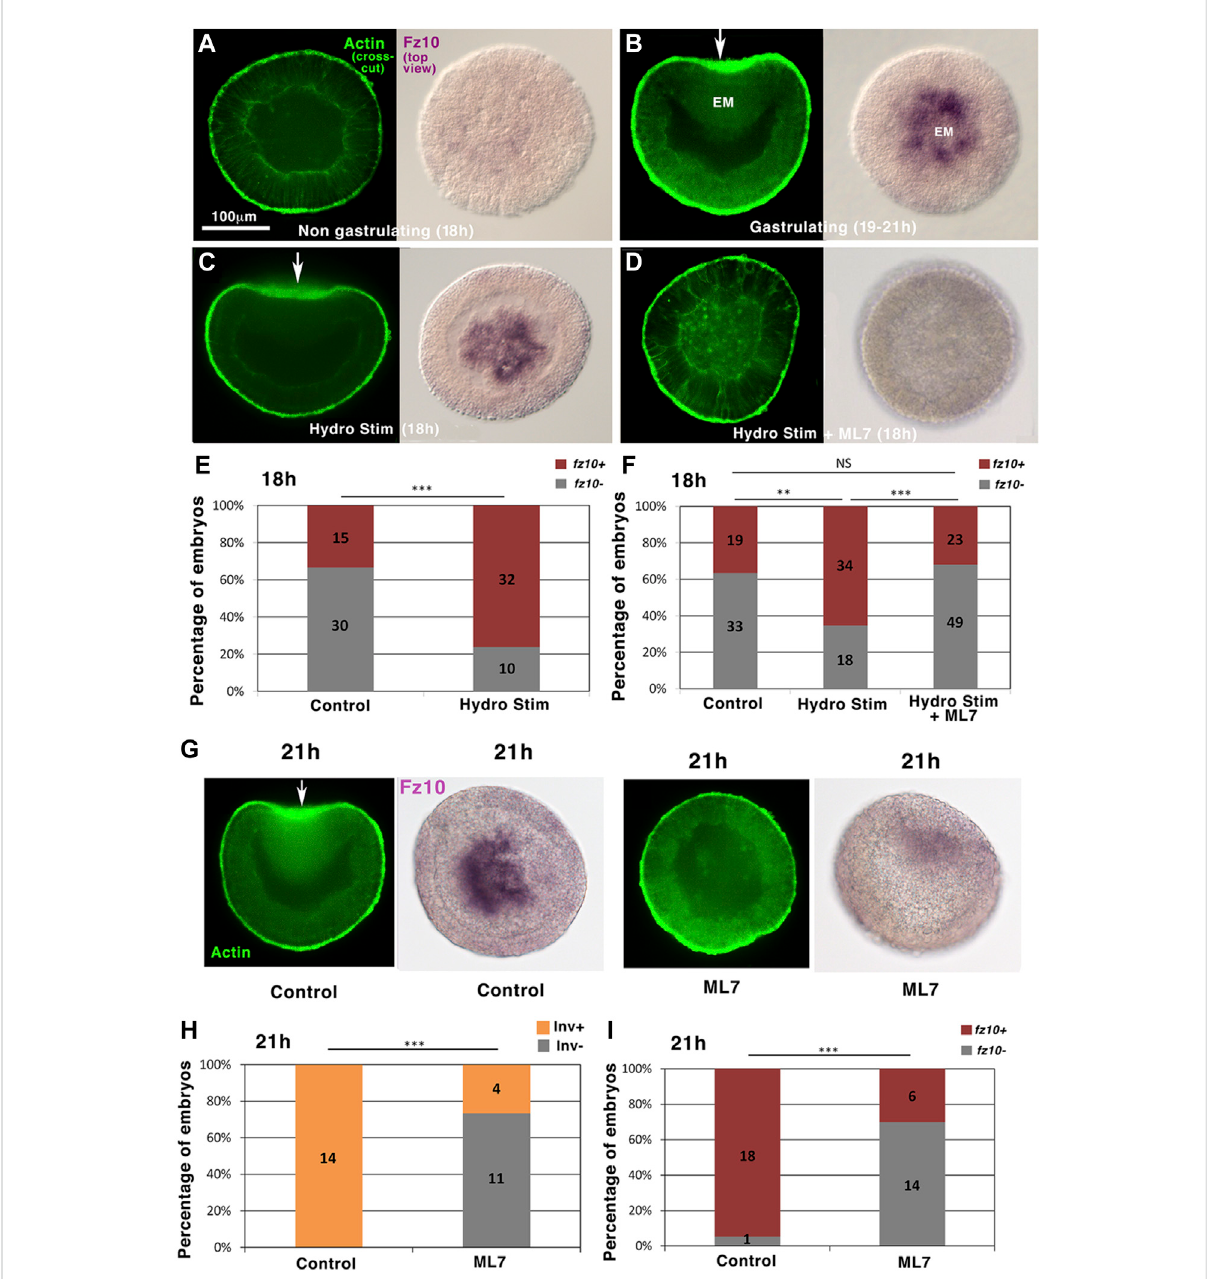
FIGURE 3 Hydrodynamically induced and endogenous gastrulation of Nematostella embryos stimulates the endomesodermal fz10 gene expression downstream of mechanical stimuli in a Myo-II-dependent process. (A) fz10 expression in 18 h non-invaginating embryos (B) and in the invaginating endomesoderm of 21 h embryos. (C) fz10 expression in the invaginating tissue of 18 h hydrodynamically stimulated embryos (D) and in hydrodynamicallystimulatednon-gastrulatingembryostreatedwithML7. (E,F) Quantitativeanalysis.n Control =45andn HydroStim =42, p =9.10 – 5 , and n Control = 52 and n HydroStim = 52, p = 5.7.10 – 3 , n HydroStim = 52 and n HydroStim+ML7 = 72, p = 2.7.10 – 4 . Control of (F) ethanol, vehicle of ML7. Fisher statistictest. (G) fz10 expressioninnon-gastrulatingembryosML7-treated21 hembryos (H,I) andquantitativeanalysis.n Control =14andn ML7 =15, p = 5.10 – 5 , n Control = 19 and n ML7 = 20, p = 3.9.10 – 5 . Control: ethanol, vehicle of ML7. Statistical test: Fisher. N = 2 biological replicates. The scale bar is 100 μ